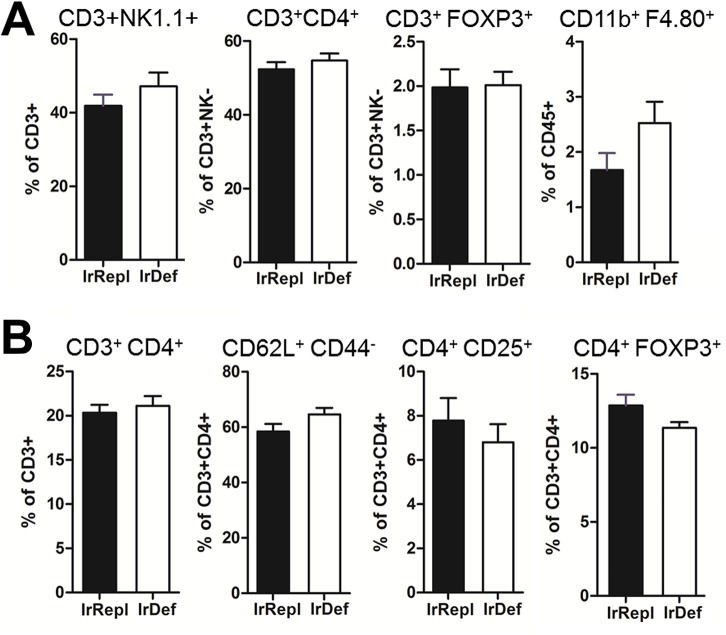
Influence of iron levels on the immunophenotype of intra-hepatic (A) and spleen (B) leukocytes.Mice were fed for 3 weeks with an iron deficient (IrDef) or iron replete (IrRepl) diet. Bar plots show the frequency (mean and SEM) of specific leukocyte subsets in the liver (A) and spleen (B), as assessed by flow cytometry after excluding dead cells.